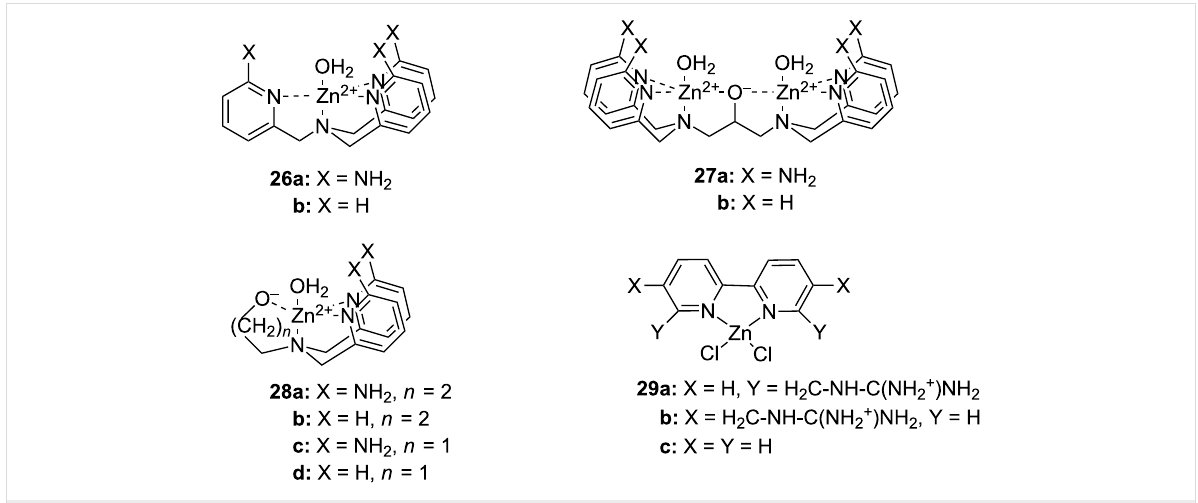
macrocycles such as 1,5,9-triazacyclododecane (TACD), 1,4,7- triazacyclononane (TACN), and their derivatives [159,160], as well as Cu 2+ complexes of terpyridine (TerPy), bipyridine (BiPy) and their derivatives, are among the most frequently studied species. In the case of lanthanide ions, the situation is opposite. Complex formation decreases the observed catalytic activity, at least partly due to blocked gel formation. Further- more, lanthanide complexes with neutral ligands tend to be unstable and ligands with side arms that encapsulate the lanthanide ions are required [161,162]. Ligands with negatively charged side arms form the most stable complexes, but a nega- tive charge generally decreases the catalytic activity. In addi- tion to improved solubility, a ligand may enable ligation of the metal complex to various structures. This is necessary in a num- ber of applications, which are outside the scope of the present